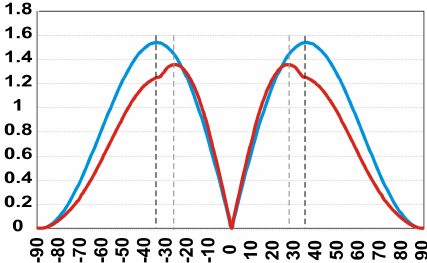
Fig. 3. The latitudinal distributions of a dimensionless gradient of the moment of inertia of the infinitely thin disks (the G(h) ∗ values) are presented for the homogeneous Earth (blue line) and for the heterogeneous Earth (red line). Horizontal axis is angular latitudes. Vertical axis gives the G(h) ∗ values. Maximum values marked as dashed